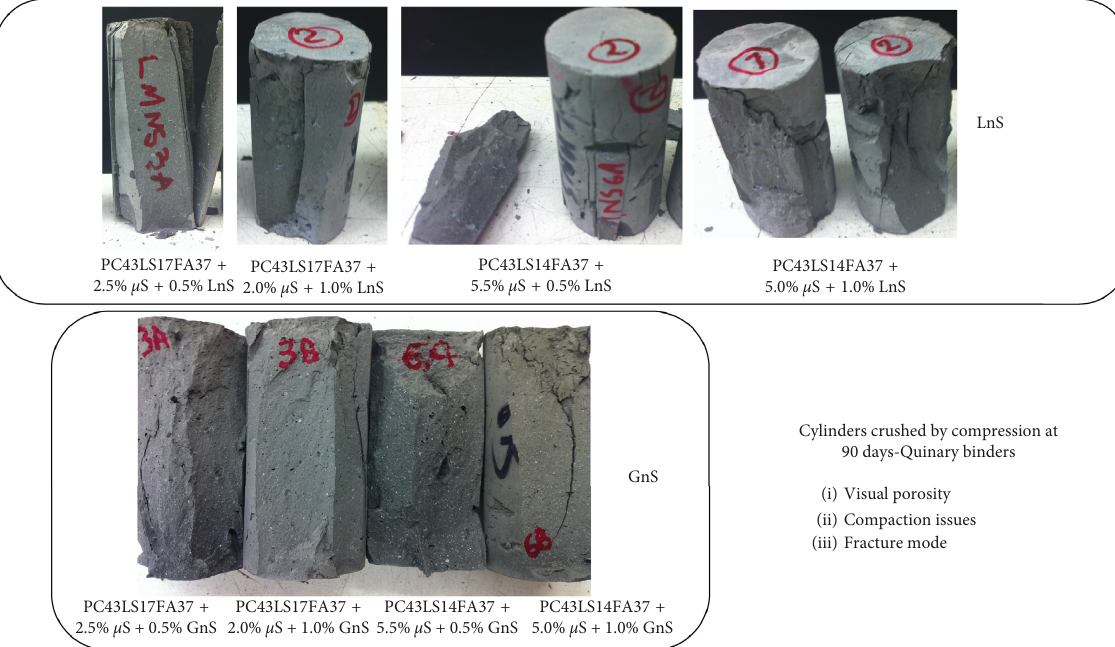
Figure 9: Crushed cylinders of μ S and LnS or μ S and GnS nanocomposite binders based on PC43LS20FA37.